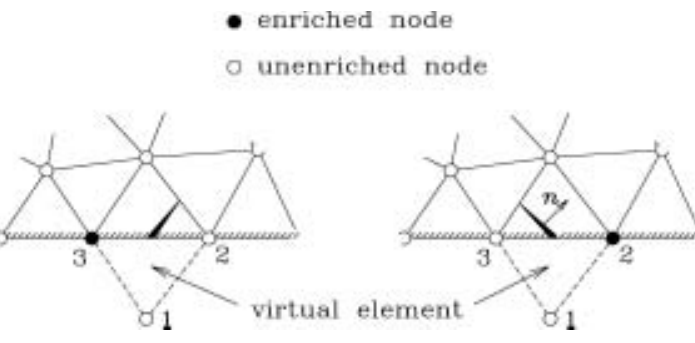
Fig. 4. Enrichment scheme for crack initiating at the edge of a